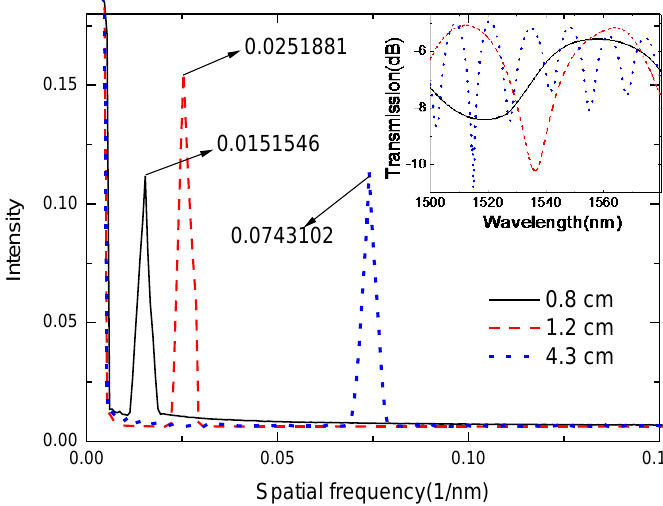
Figure 4. The spatial frequency spectra of Mach–Zehnder interferometers (MZIs), and the inset is the correlated interference spectra with different sensing arms of 0.8 cm, 1.2 cm, and 4.3 cm.